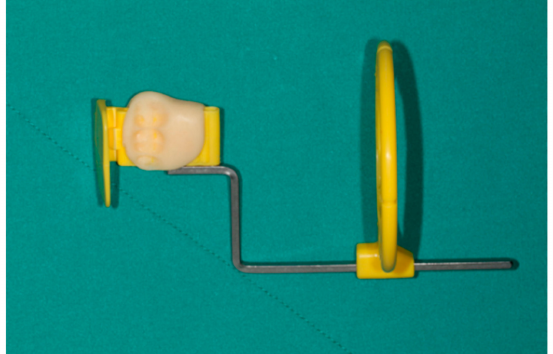
Figure 4. The customized occlusal bite jig was fabricated attach to film holder in each patient.